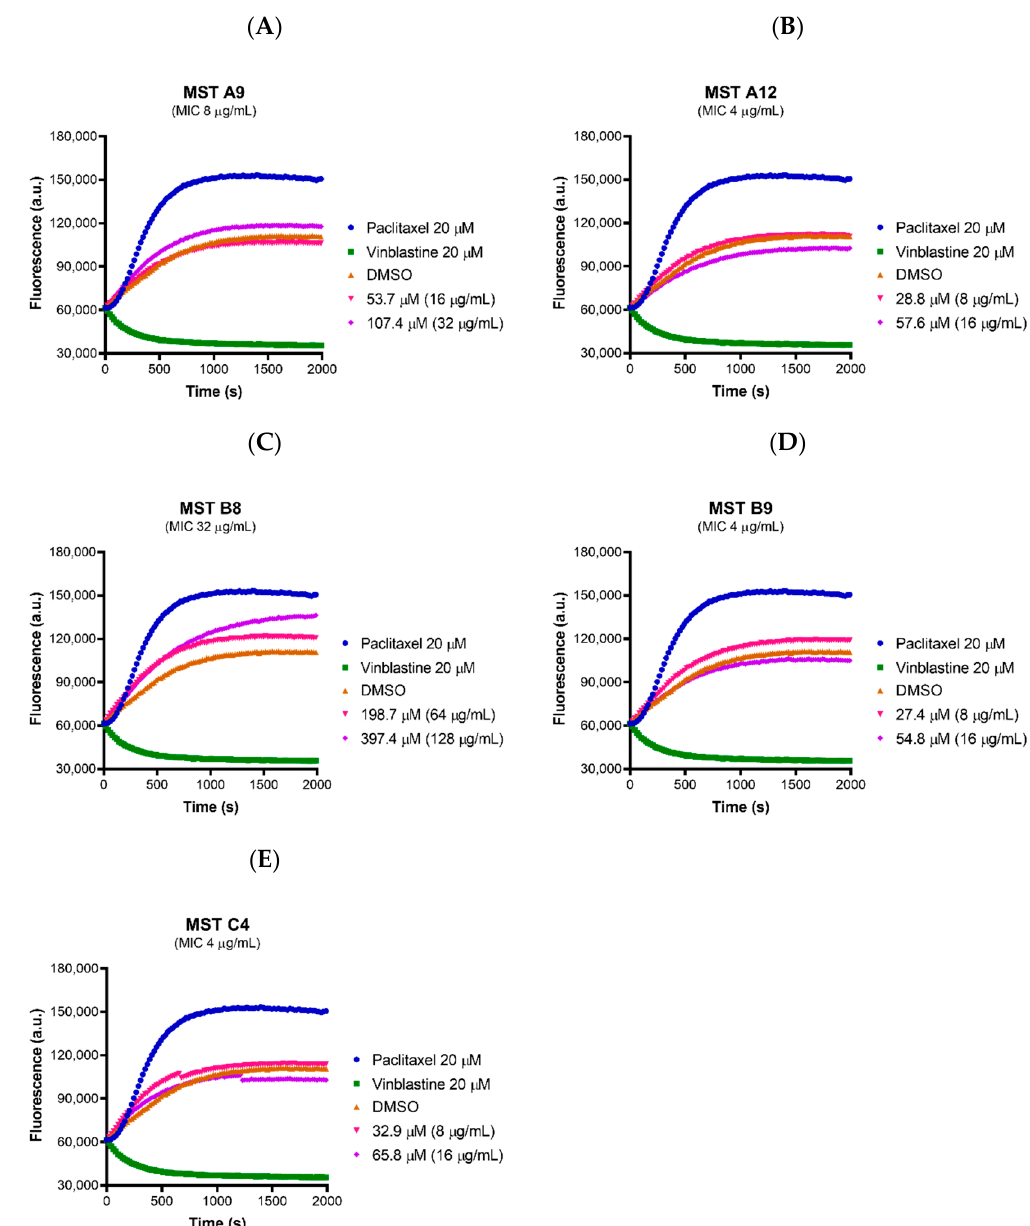
Figure 7. The MST compounds do not affect polymerization of mammalian tubulin. ( A – E ) The activity of the compounds on porcine tubulin was assessed using a commercial Tubulin Polymerization Assay Kit (Cytoskeleton, Inc.) following the protocol described by the manufacturer. The MST compounds at 2 × and 4 × MIC were pre-incubated with tubulin on ice before the reaction was initiated by the addition of 1 mM GTP. The fluorescence was measured as a function of time at A 360 and A 420 nm excitation and emission wave lengths, respectively, at the constant temperature of 37 °C. A 2% ( v / v ) DMSO (brown curves) vehicle control was used with paclitaxel (polymerization stabilizer; blue curves) and vinblastine (polymerization inhibitor; green curves) at 20 µ M each also included as